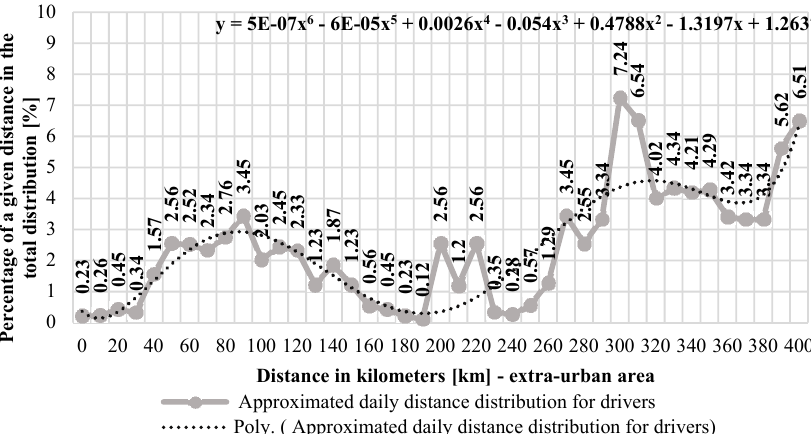
Distance in kilometers [km] - urban area Approximate monthly distance distribution for drivers Poly. ( Approximate monthly distance distribution for drivers) Figure 2. Monthly distance distribution for ICEVs, PHEVs, and BEVs operated in urban mode— approximate value based on experimental tests.